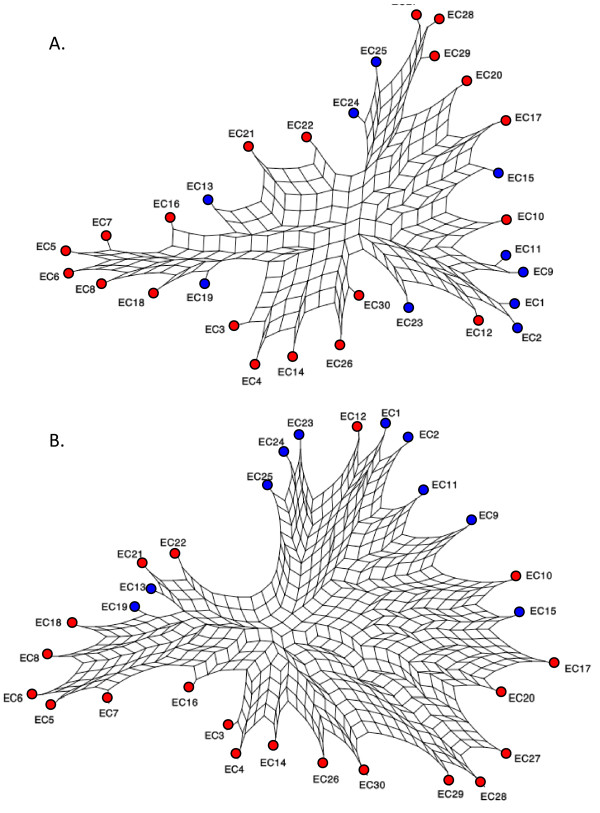
Split decomposition graph of the E. coli strains. Visual representation of the conflict in the phylogenetic signals among 30 strains of E. coli, for (A) the core genes (n = 2317) and (B) the shell genes (n = 3511). The strains are tagged for pathogenicity with red nodes for PATH and blue nodes for NON-PATH E. coli. Splitstree4 http://www.splitstree.org/ was used for both display, with the Neighbor-Net algorithm [51].